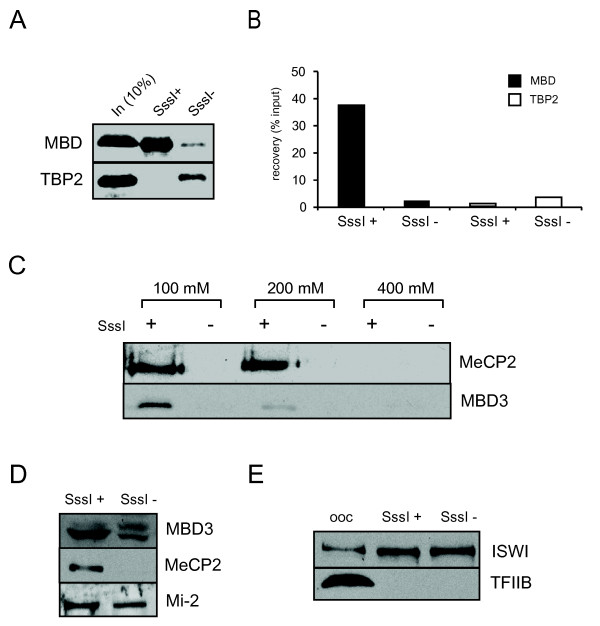
DNA affinity precipitation of recombinant and endogenous oocyte extracts proteins. (A) In vitro translated, S35 labeled MBD domain of MeCP2 specifically binds the methylated immobilized probe (SssI+). Conversely, the negative control (TBP2) displays only residual affinity for non-methylated DNA (SssI-). (B) Quantification of DNA methylation-specific binding using the Image-quant software. ~35% of the recombinant MBD domain is recovered after washing and elution from methylated DNA oligos. (C) Western blotting of eluates obtained after 100 mM, 200 mM and 400 mM KCl washes. MeCP2 tolerates 100 mM and 200 mM KCl concentration in the washing buffer whereas most of the MBD3 is eluted with 200 mM salt. (D) DNA affinity precipitation of MBD3, MeCP2 and Mi-2 from oocyte extracts. MeCP2 displays strong preference for methylated DNA, whereas Mi-2 and MBD3 bind both methylated and unmethylated DNA. The short form of MBD3, however, displays a preference for methylated DNA. (E) Establishment of positive (ISWI) and negative (TFIIB) controls for DNA affinity precipitation.